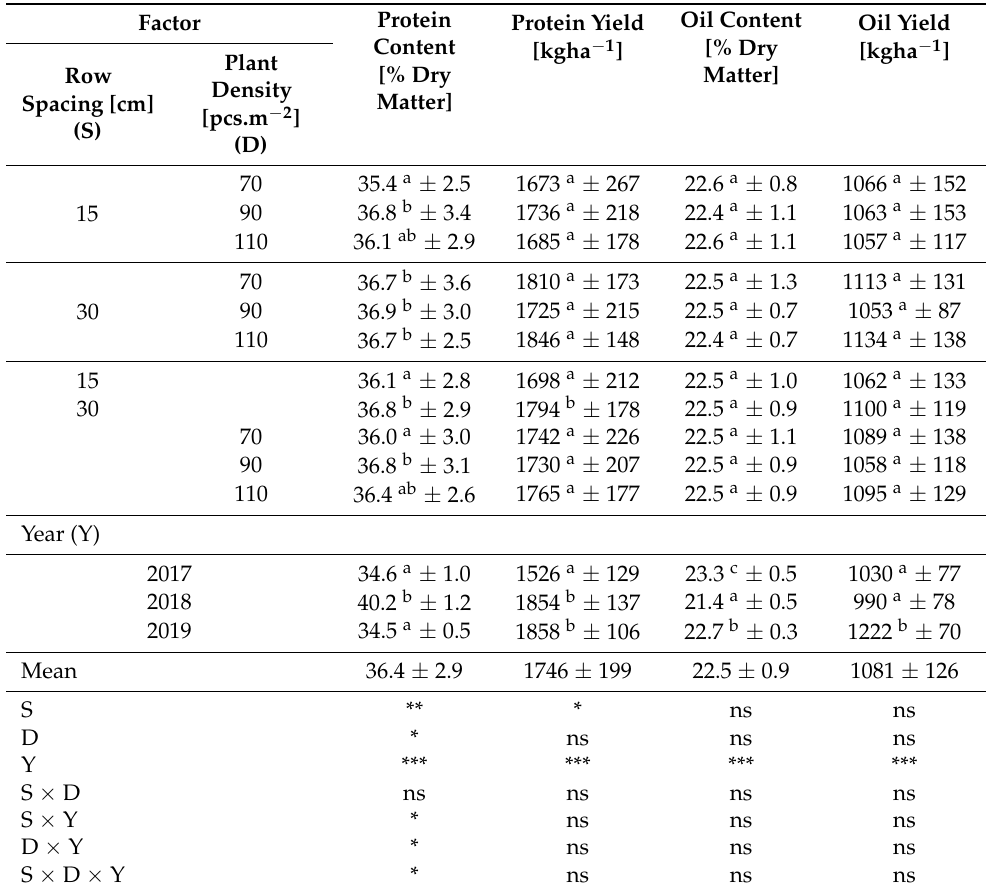
Table 6. Effect of row spacing and sowing density on chemical seed composition and protein and oil